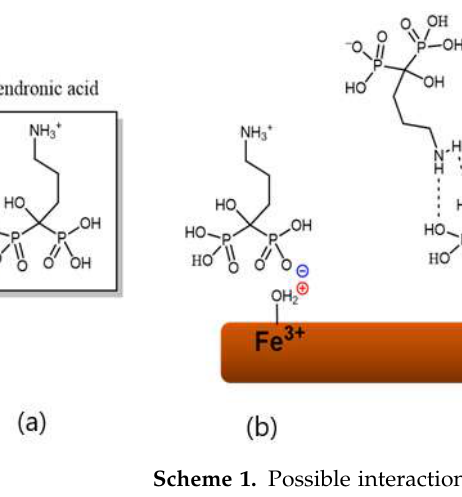
Table 2. Experimental conditions for coating the BSHF NPLs with